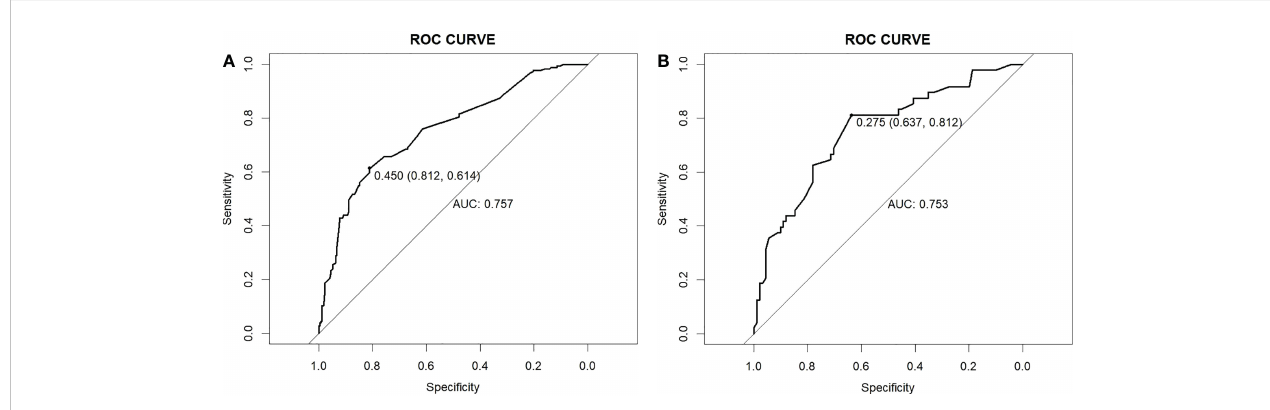
FIGURE 3 ROC curves. (A) Training cohort. (B) Validation cohort. ROC, receiver operating characteristic; AUC, area under the ROC curve.